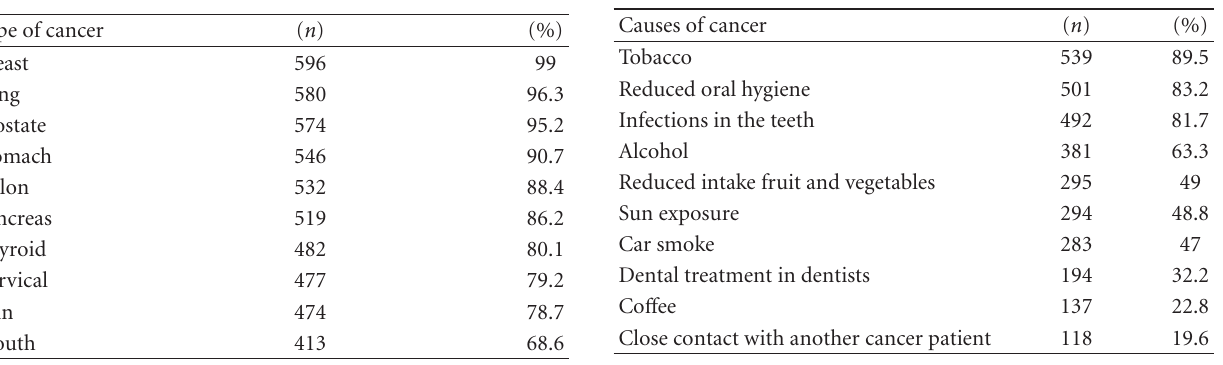
Table 2: Most mentioned cancers in the survey. Table 3: Most risk factors or causes mentioned for oral cancer.